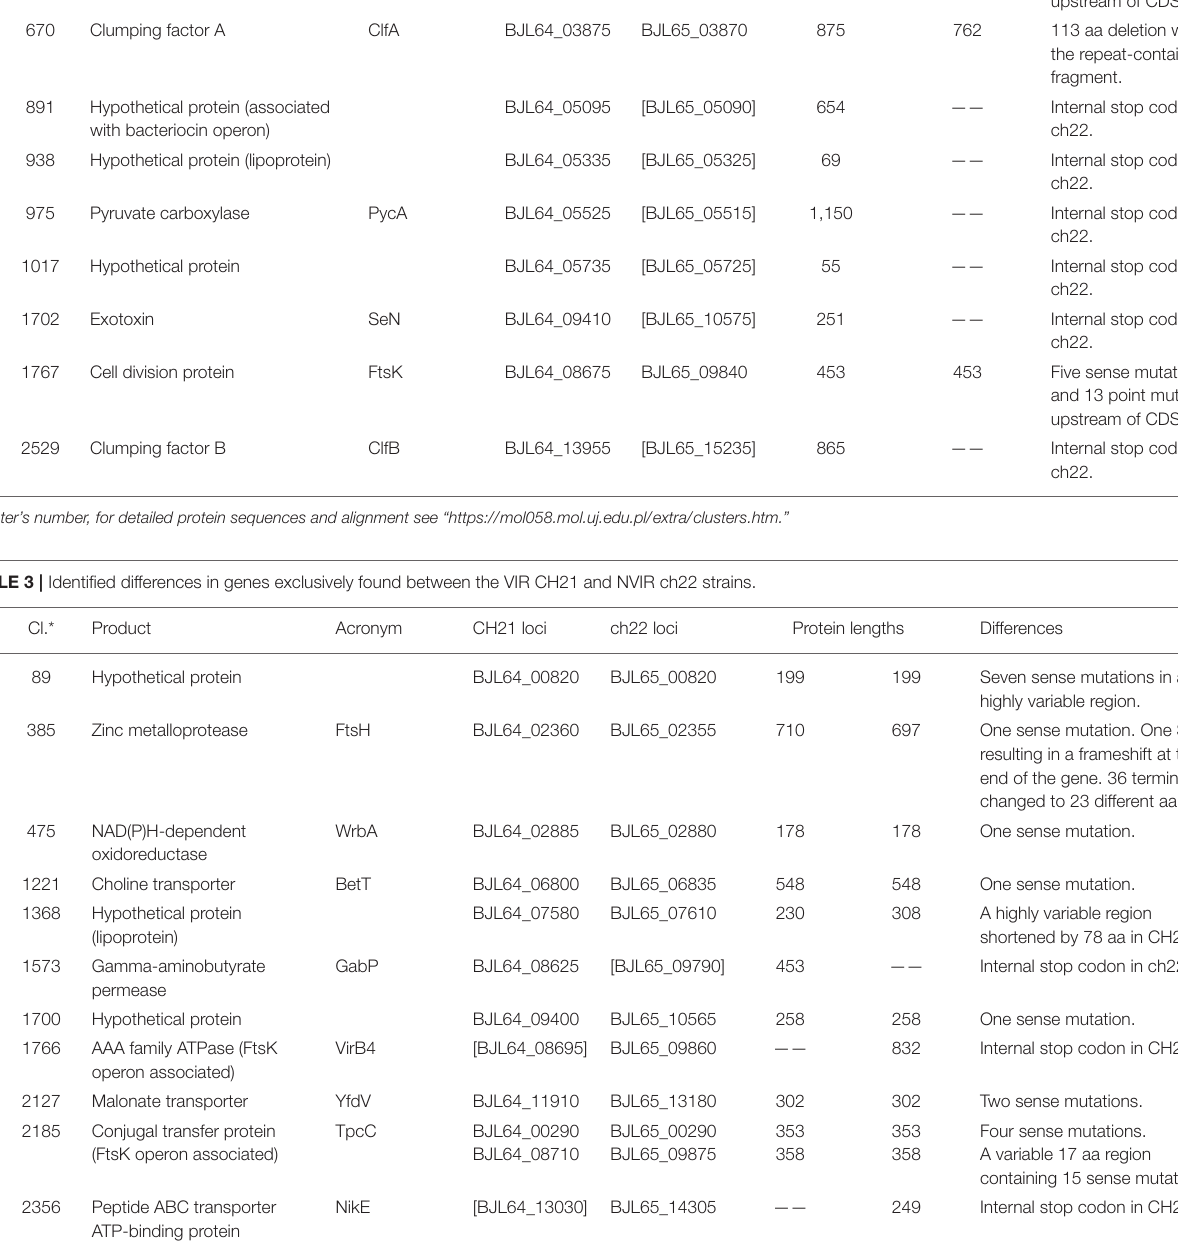
TABLE 2 | Differences in genes between VIR and NVIR strains exemplified by differences identified in the VIR CH21 and NVIR ch22 strains. No.